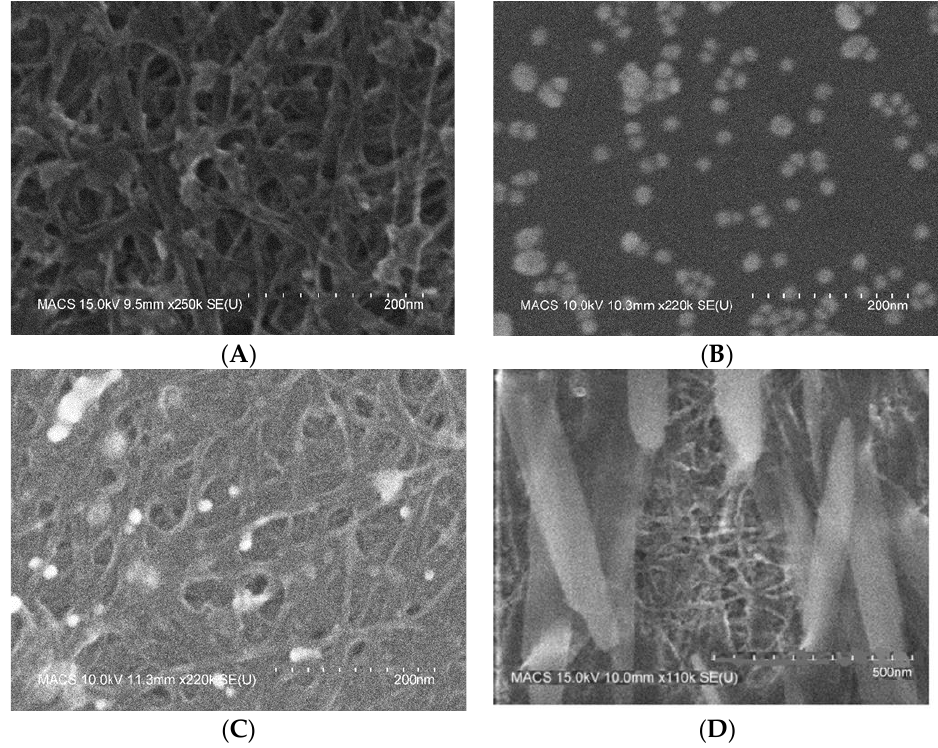
Figure 2. FE-SEM images for materials deposited onto a silicon substrate ( A ) SWCNTs-COOH ( B ) Au NPs ( C ) Composite Material 1 ( D ) composite Material 2.